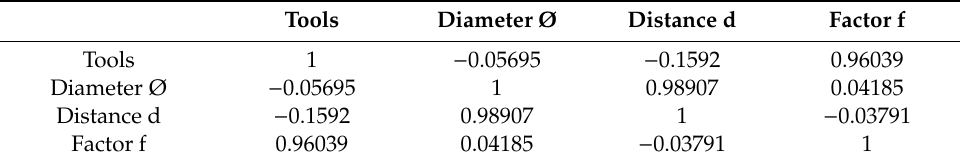
Table 5. Correlation matrix A of data presented in Table